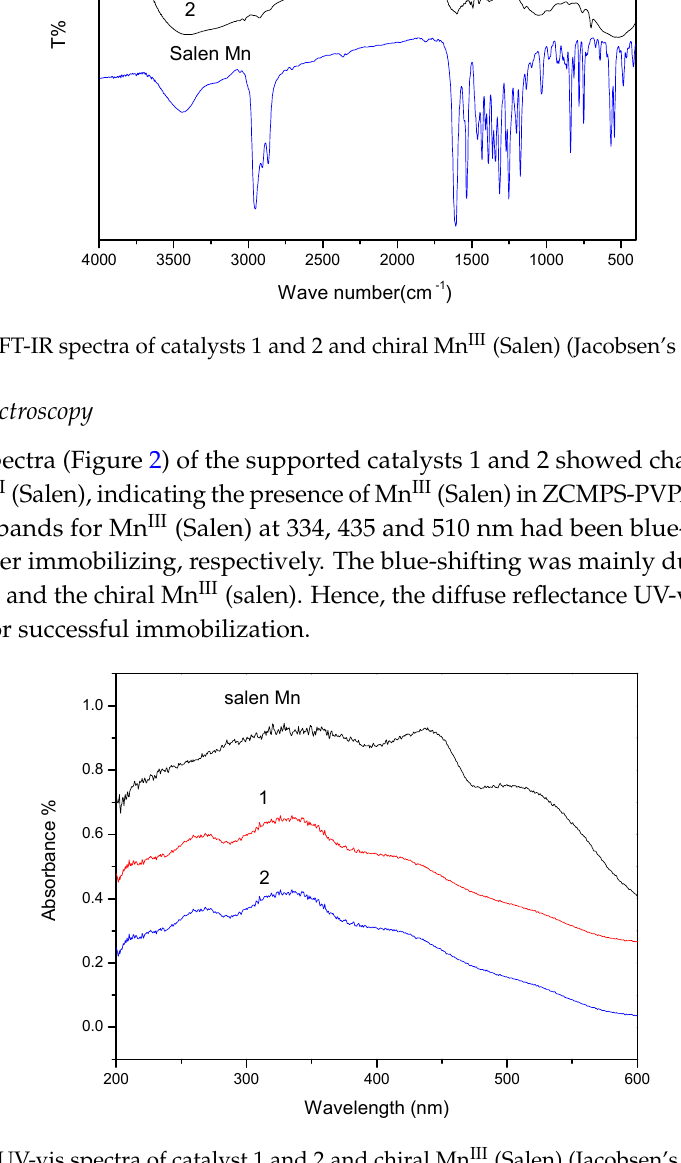
Figure 2. UV-vis spectra of catalyst 1 and 2 and chiral Mn III (Salen) (Jacobsen’s catalyst 4).